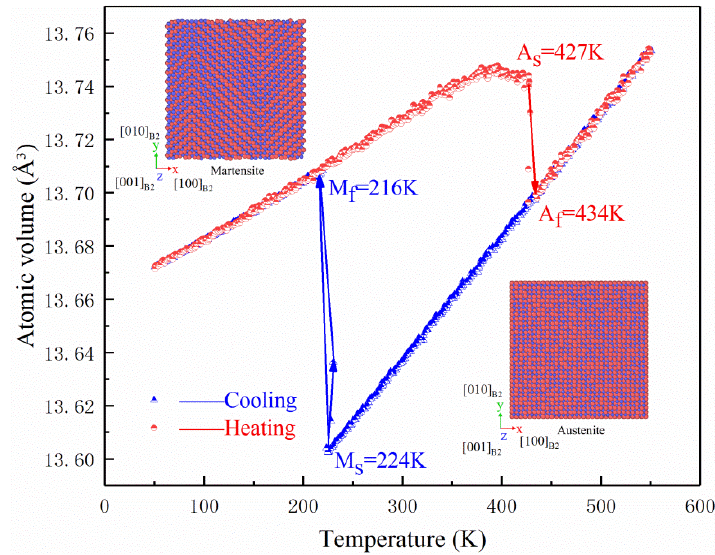
Figure 5. Variation of atomic volume with temperature in the MD simulation of the temperature- induced martensitic transformation of NiTi SMA.